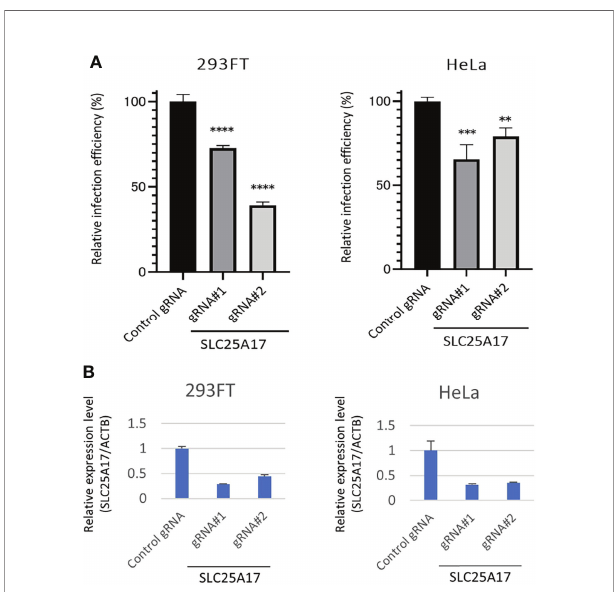
FIGURE 4 | Evaluation of the effect of SLC25A17 mRNA expression on HPV infectivity. (A) x3000;293FT-, and HeLa-Cas9 cells were edited with a control or two different SLC25A17 gRNAs. Bulk cells were inoculated with HPV-PsV- GFP-TK and processed to examine GFP expression using fl ow cytometry. (n = 3, one-way ANOVA with a Dunnett ’ s multiple comparison test compared to control) ** P < 0.01; *** P < 0.001; **** P < 0.0001. (B) qRT-PCR analysis of mRNA expression in 293FT-, and HeLa-Cas9 cells. The relative expression of SLC25A17 is shown. The values are normalized to